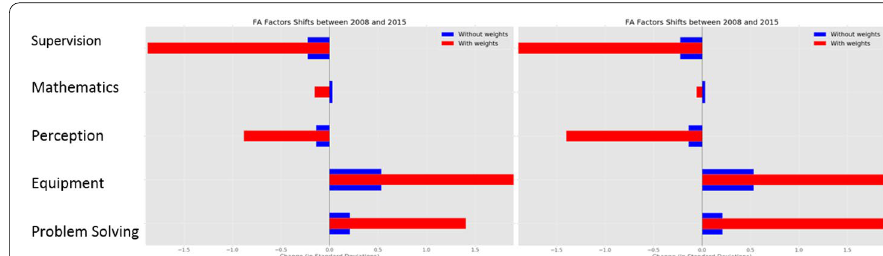
Fig. 13 FA GCC (left) and USA (right) oil & gas LSI